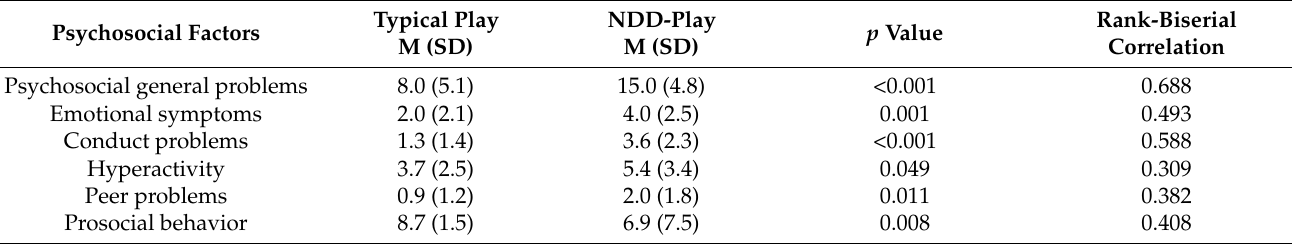
Table 3. Psychosocial factors according to play performance ( n =